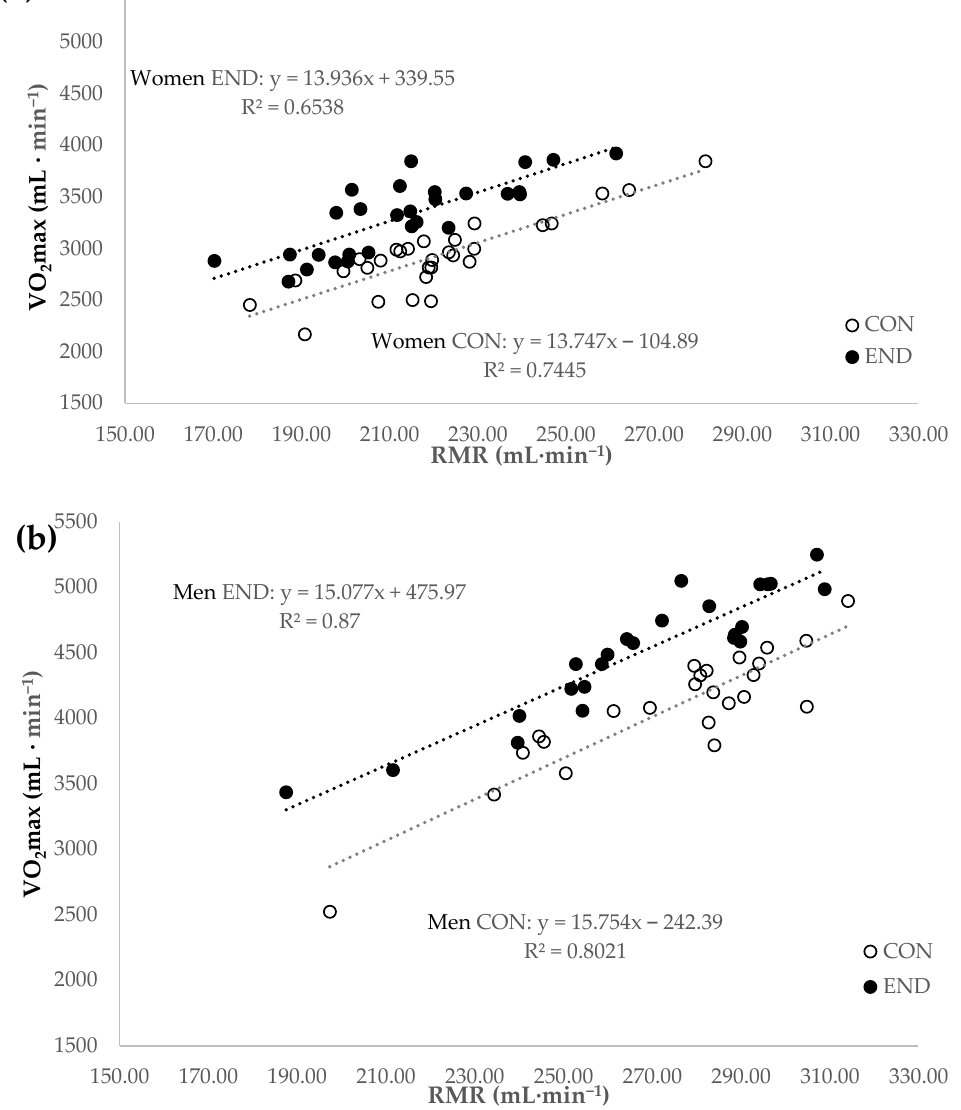
Figure 1. Resting metabolic rate (RMR) and maximum oxygen consumption (VO 2 max) in ( a ) women and ( b ) men who were endurance trained subjects (END) and healthy controls (CON).